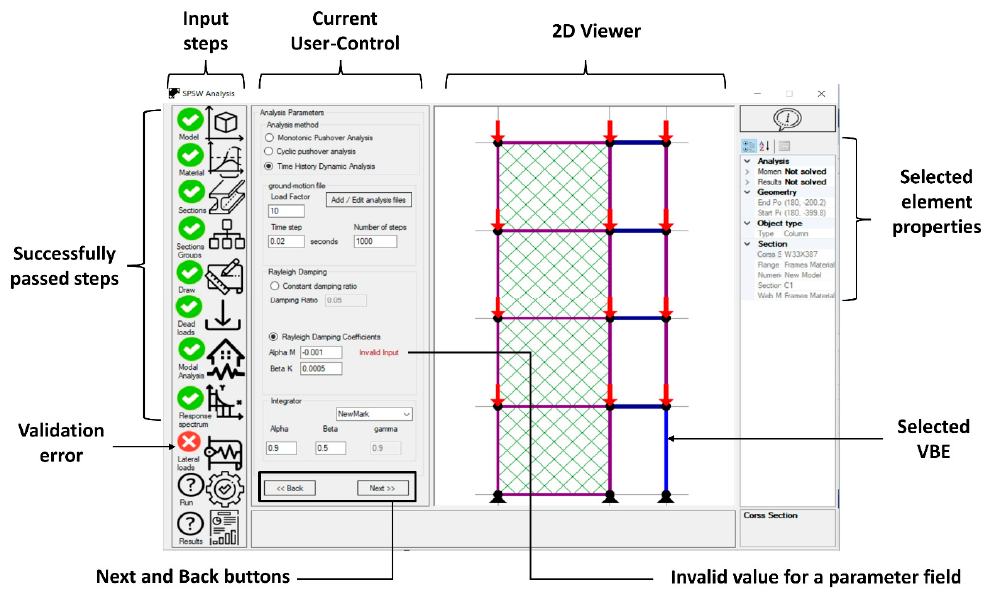
Figure 7. Illustration for INSPECT-SPSW components. Table 1. The primary user controls for INSPECT-SPSW.